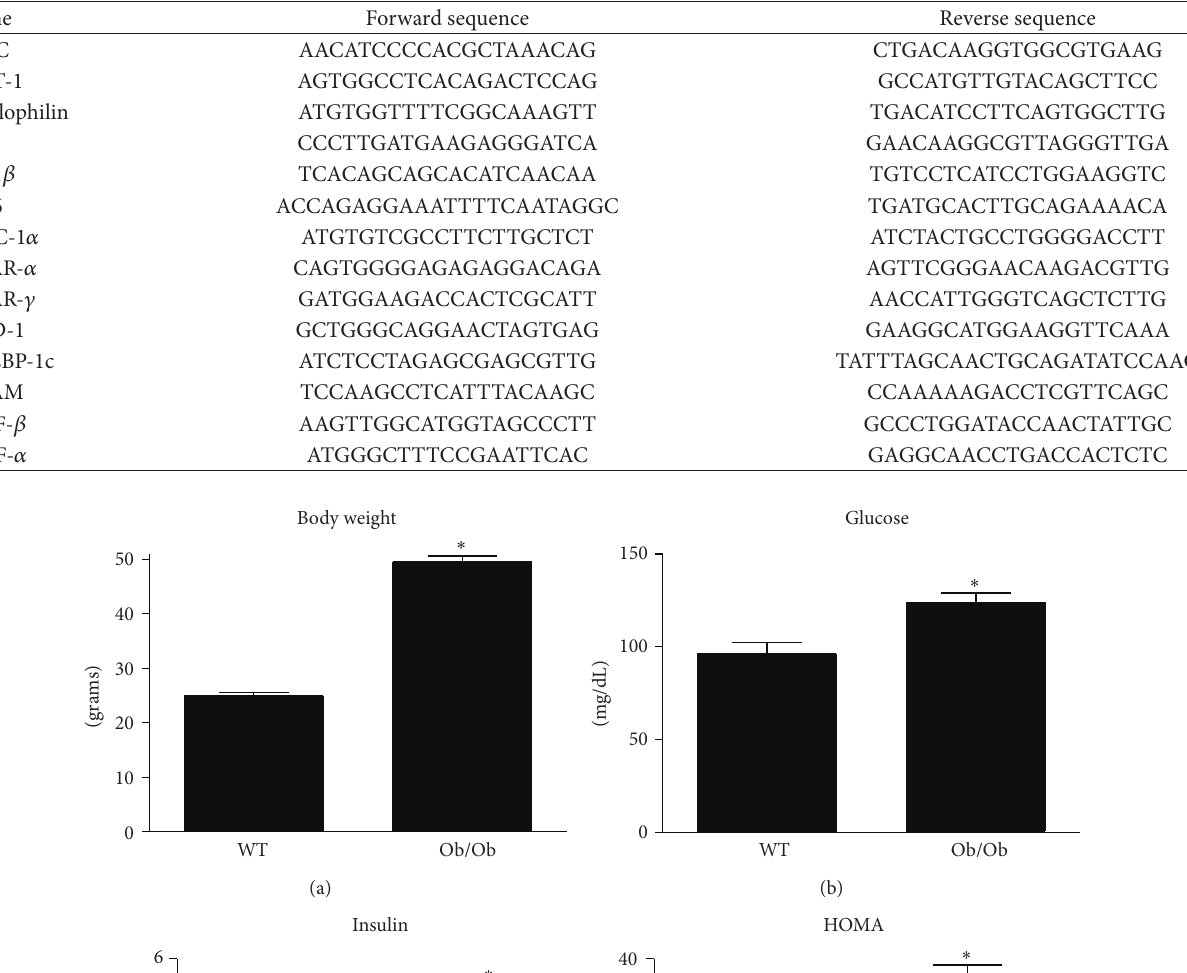
T 1: qRT-PCR primer sequences.